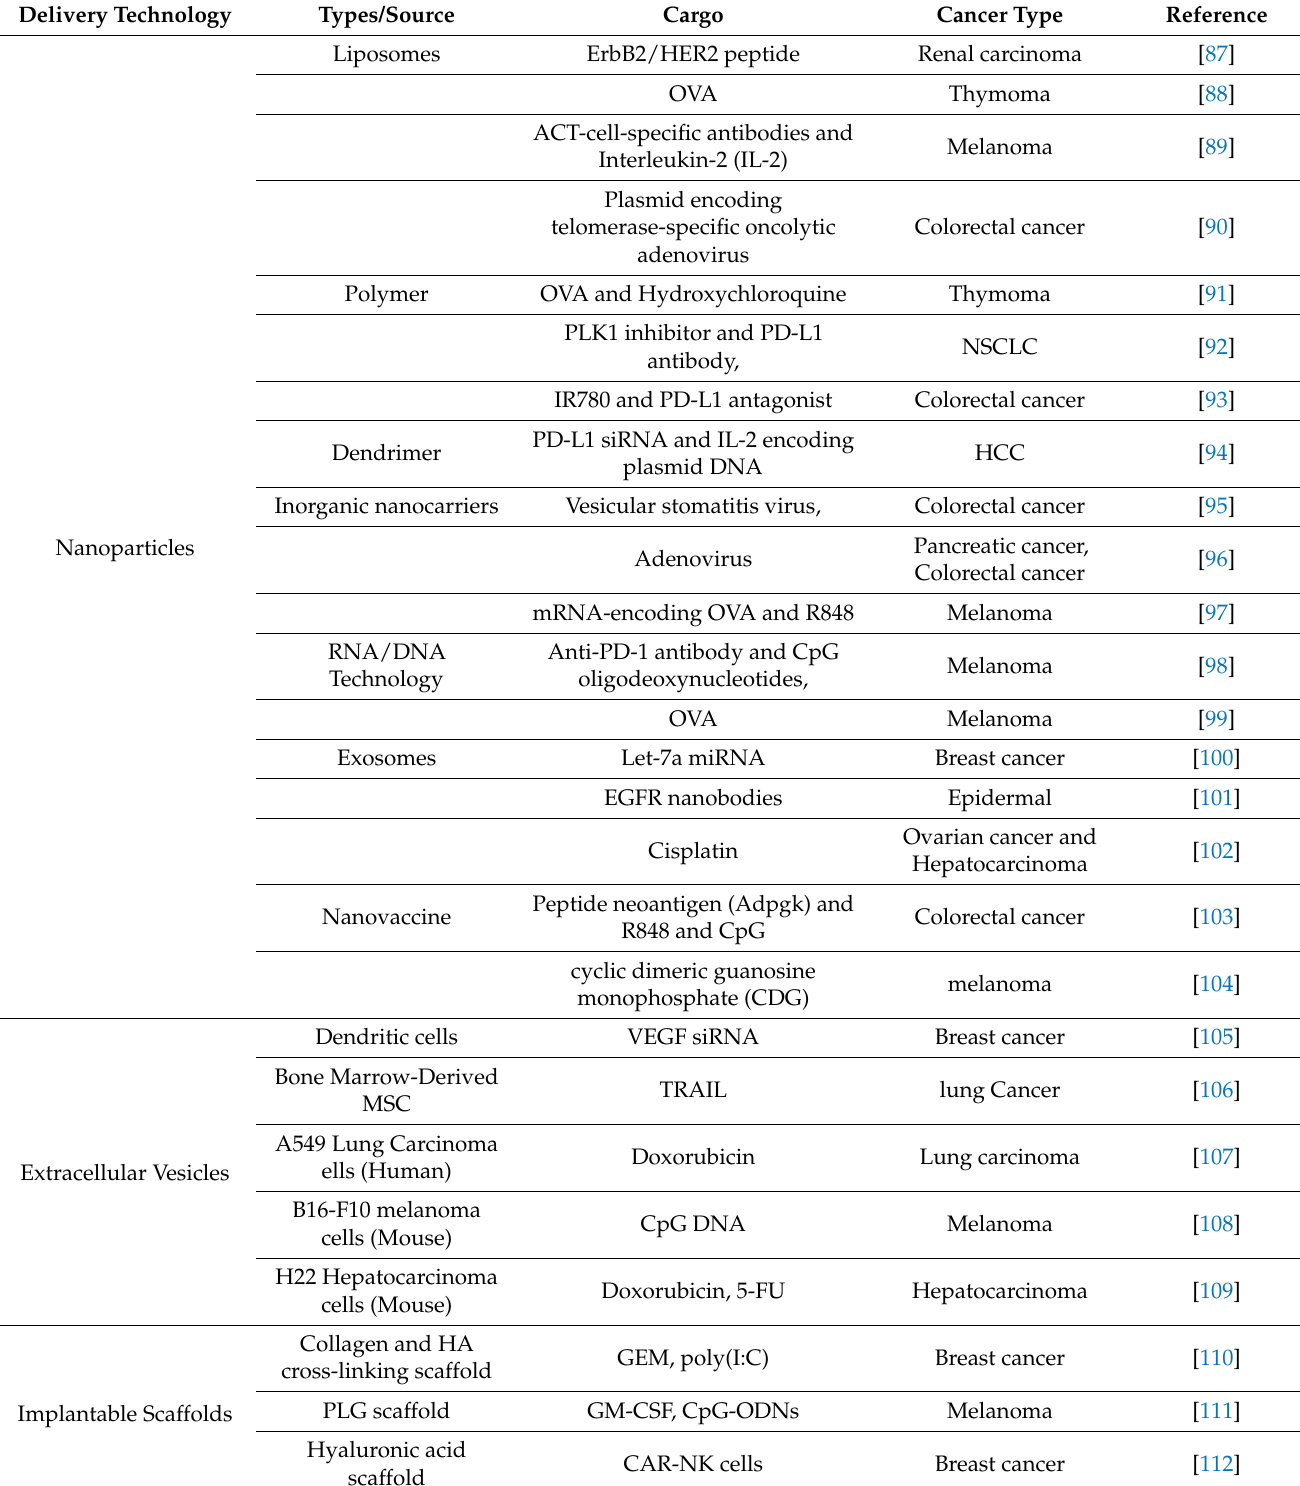
Table 3. Delivery techniques for cancer